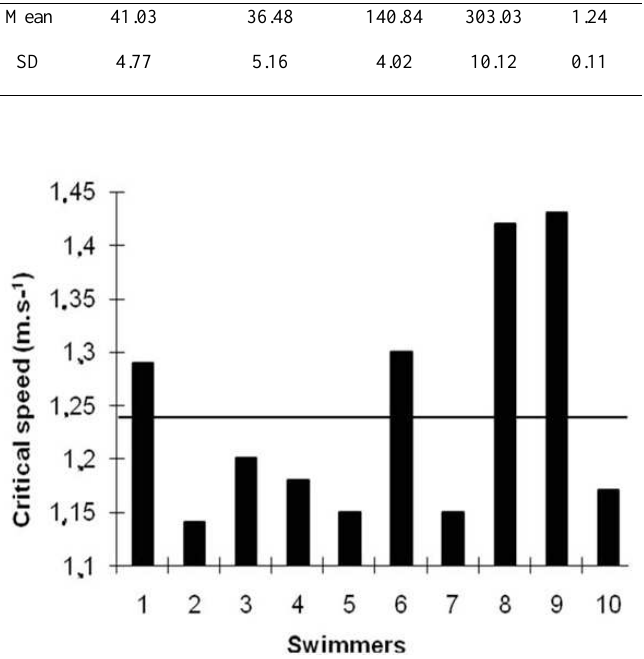
Figure 1. Individual critical speed compared to mean group critical speed.